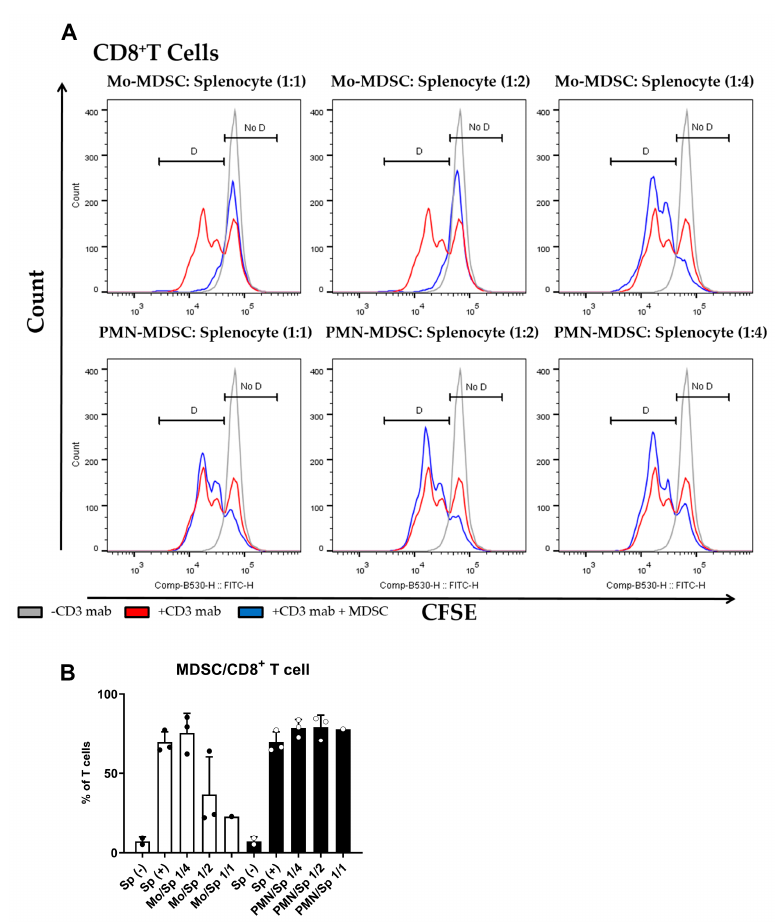
Figure 3. MDSC-mediated suppression of CD8 + T cell proliferation. ( A ) CFSE-labelled splenocytes were activated by anti-mouse CD3 antibody and co-cultured (blue) with Mo-MDSCs (upper row) or PMN-MDSCs (lower row) isolated freshly from LLC tumors at the indicated cell ratios. As controls, stimulated splenocytes (red) and unstimulated splenocytes (grey) were cultured